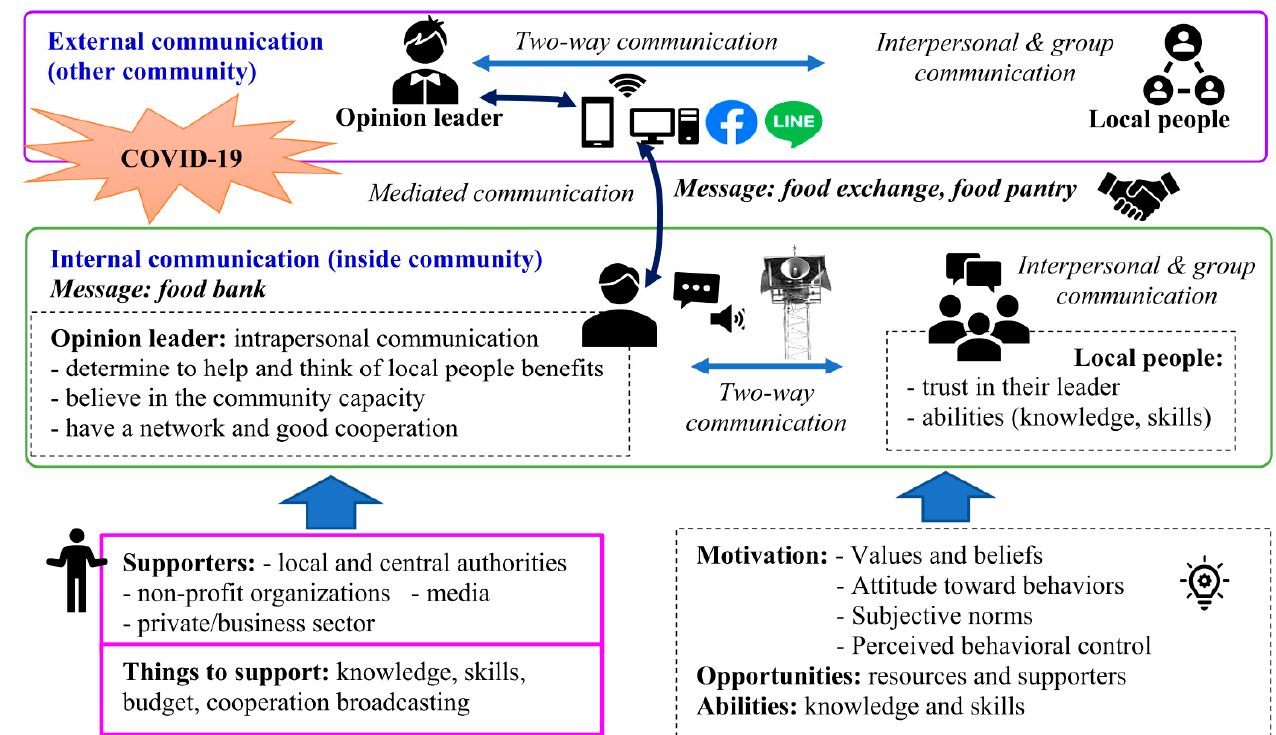
Figure 2. Effective communication framework to strengthen sustainable food security during the COVID-19 pandemic and in the time of crisis.